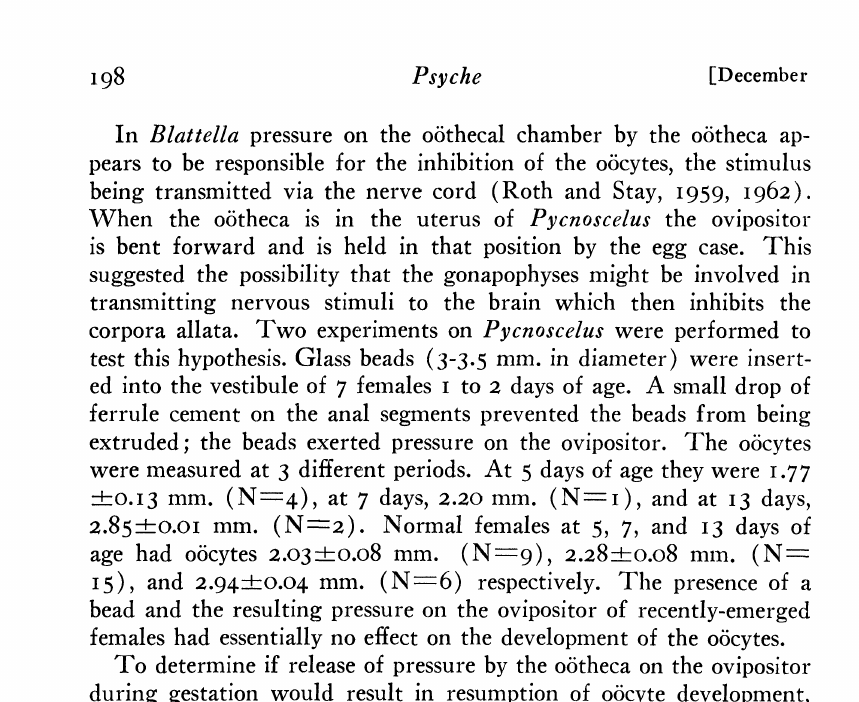
Fig. 14. Reproduetive organs of Byrsotria [umigata. A. Normal mated female sham operated (nerve cord) when pregnant 38 days and dissected after 70 days of pregnancy. The eggs (arrows) in the ovaries are undeveloped; U--uterus containing o6theea. B. Mated female whose o6theea was removed 40 days after oviposition and dissected 32 days later. The eggs in the ovaries have almost matured (6.22 ram. long). C. Mated female whose nerve cord was severed at 39 days of pregnancy and disseeted 32 days after the operation (71 days pregnant). The eggs (arrows) in the ovaries have nearly matured (5.88 mm. long); U=uterus containing o6theea. D. Virgin female allateetomized at one day of age. After 52 days, cor- pora allata from two females 9 to 10 days of age were implanted. Oviposition occurred 28 to 35 days after implantation of corpora allata. The eggs (arrows) in the ovary are almost full grown (5.88 mm.) although an o6theea remains in the uterus (IJ). E. Ovary of a virgin female 43 days old. The ofeytes are large and degenerating (A-D= X 2 E X